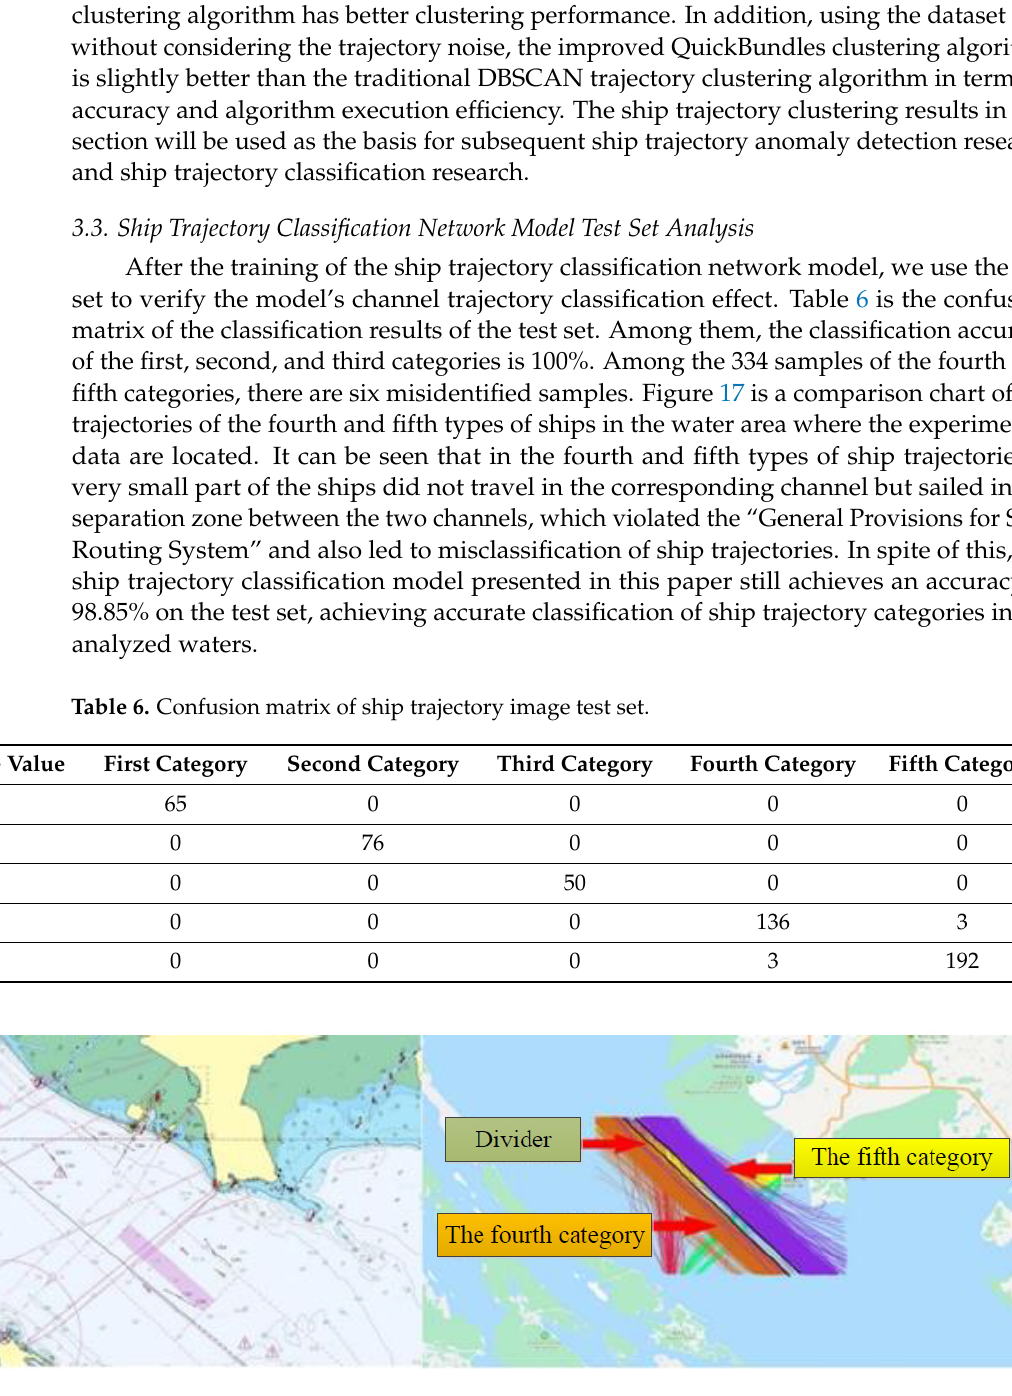
Figure 17. The fourth- and fifth-type channel information map of the water area where the experi- mental data are located.